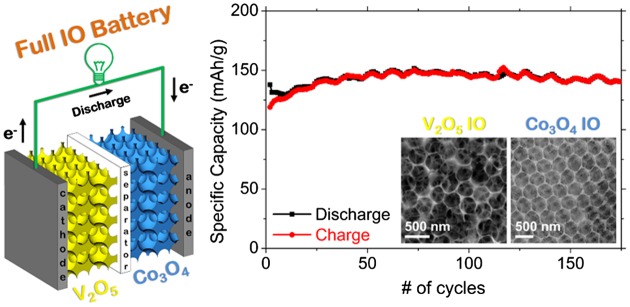
Schematic of a V2O5-Co3O4 inverse opal Li-ion battery cell. Efficient cycling without capacity fade is observed for over 175 cycles.